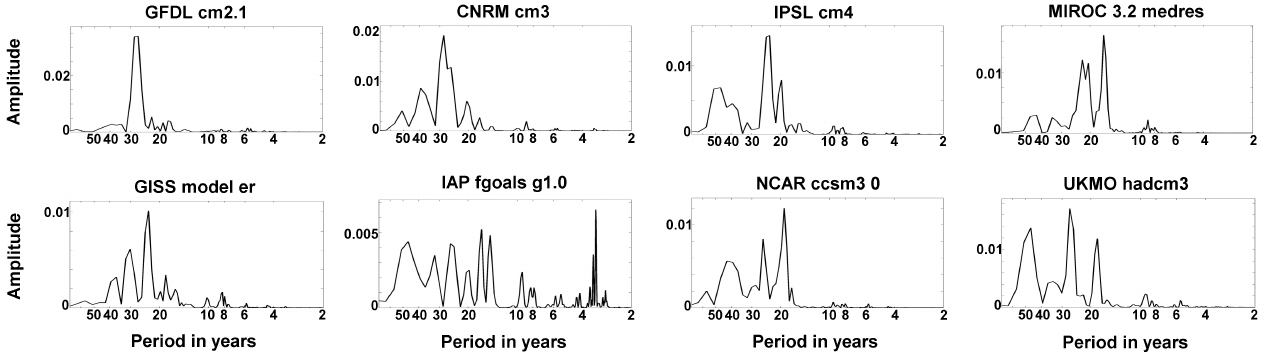
Fig. 6. Power spectra of the first PC of the set of 17-yr trend maps computed with the coupled climate model control runs. The power is plotted against the natural log of frequency so that the era under the curve in a particular frequency band is equal to the variance explained by the signal contained in this band of